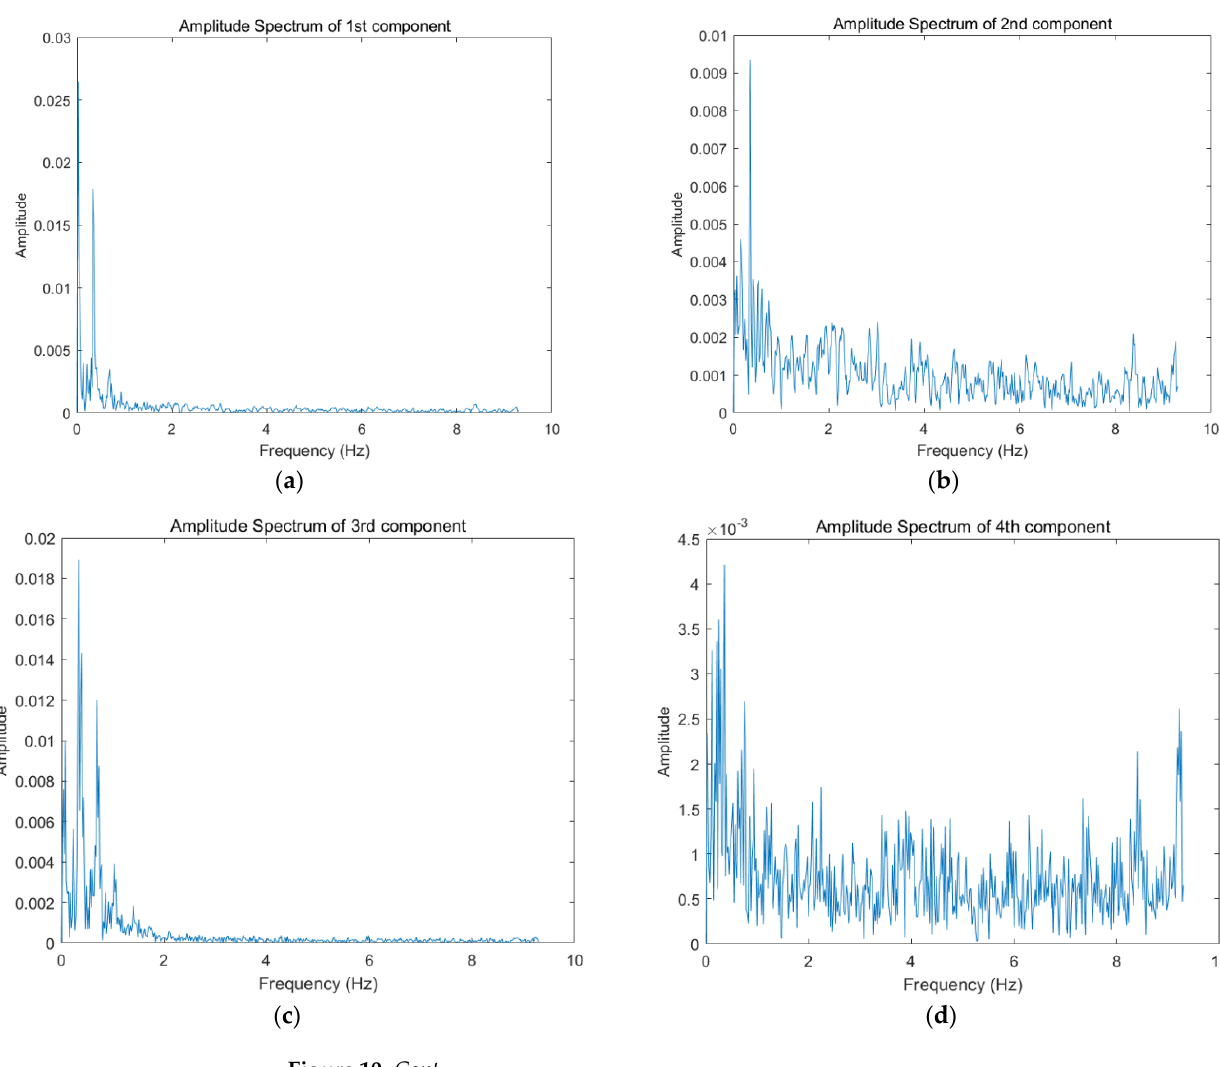
( f ) Figure 10. Amplitude spectrum of each order principal component: ( a ) Amplitude spectrum of first component; ( b ) Amplitude spectrum of second component; ( c ) Amplitude spectrum of third com- ponent; ( d ) Amplitude spectrum of fourth component; ( e ) Amplitude spectrum of fifth component; ( f ) Amplitude spectrum of sixth component. Figure 11. Energy proportion diagram of vital signs frequency band.